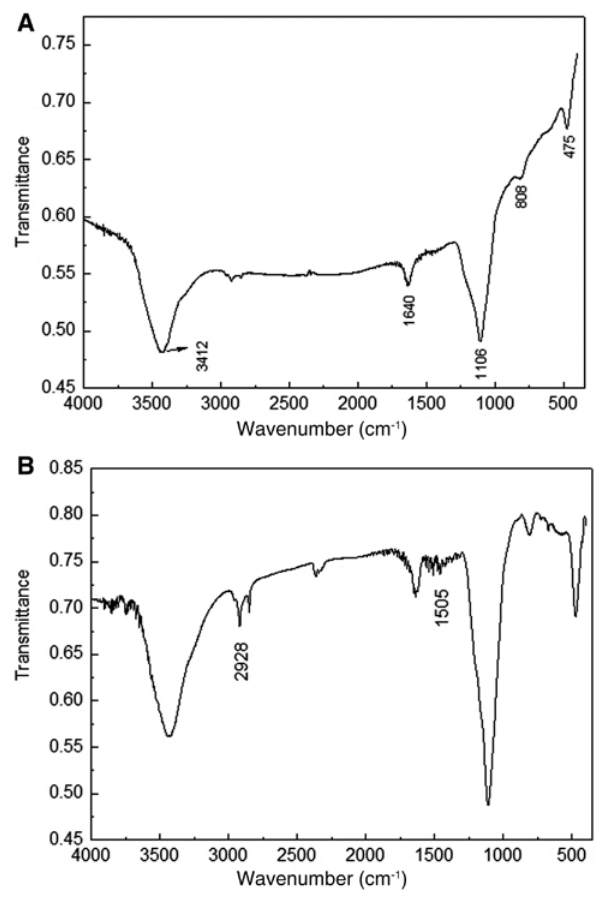
Figure 1 Infrared spectroscopy of nanosilica. (A) Unmodified. (B) Modified with KH570.